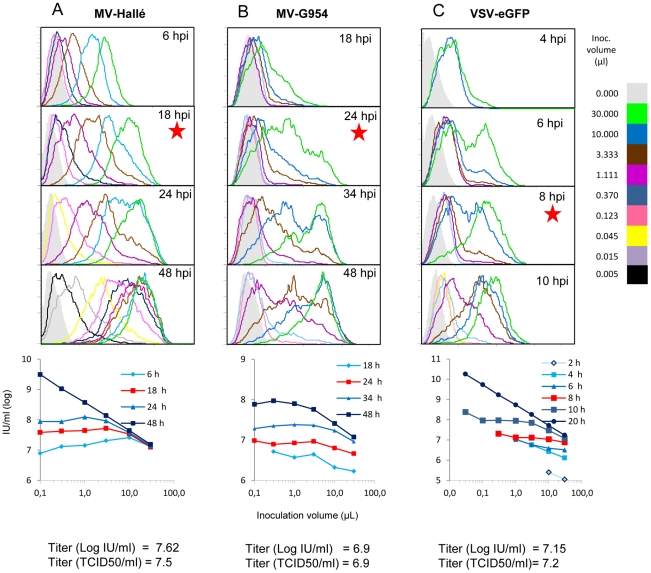
Defining the titration time for different viruses.MV-Halle (panel A), wt MV-G954 (panel B), and VSVeGFP (panel C) stocks were used in 3-fold serial dilutions to infect Vero, Vero-SLAM and Vero cells, respectively. At different times post infection, cells were collected and analyzed by flow cytometry to determine infected cells for each virus input. The optimal time for virus titration reflects the first overlap between the peaks of the most concentrated dilution and the adjacent one and is marked with a “star” on the corresponding histogram. For each dilution, titers have been calculated by applying the Poisson law, and values expressed in IU/ml as function of the inoculation volume (see the charts below the histogram panel for each virus). The red curves reflect the time when a single replication cycle has occurred. The titer is determined by the average of the values on the level curve (red) and is compared to the titer obtained by TCID50 technique below each chart.